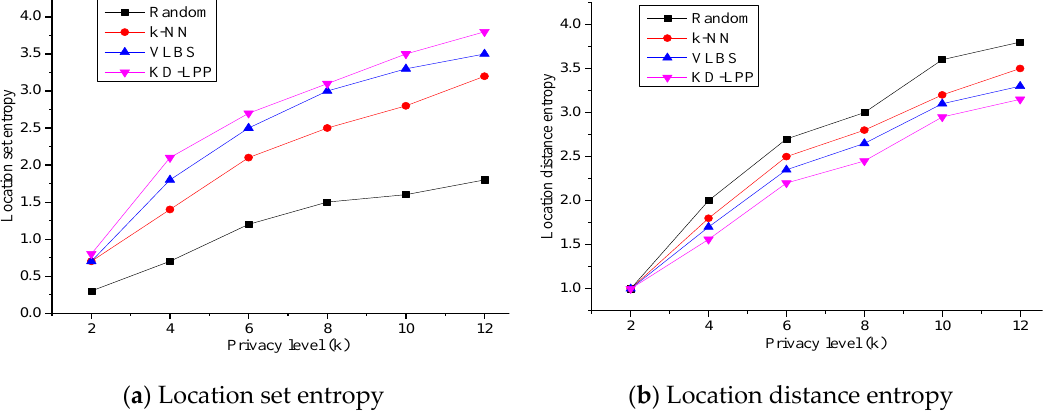
Figure 7. Effect of location set entropy and location distance entropy.